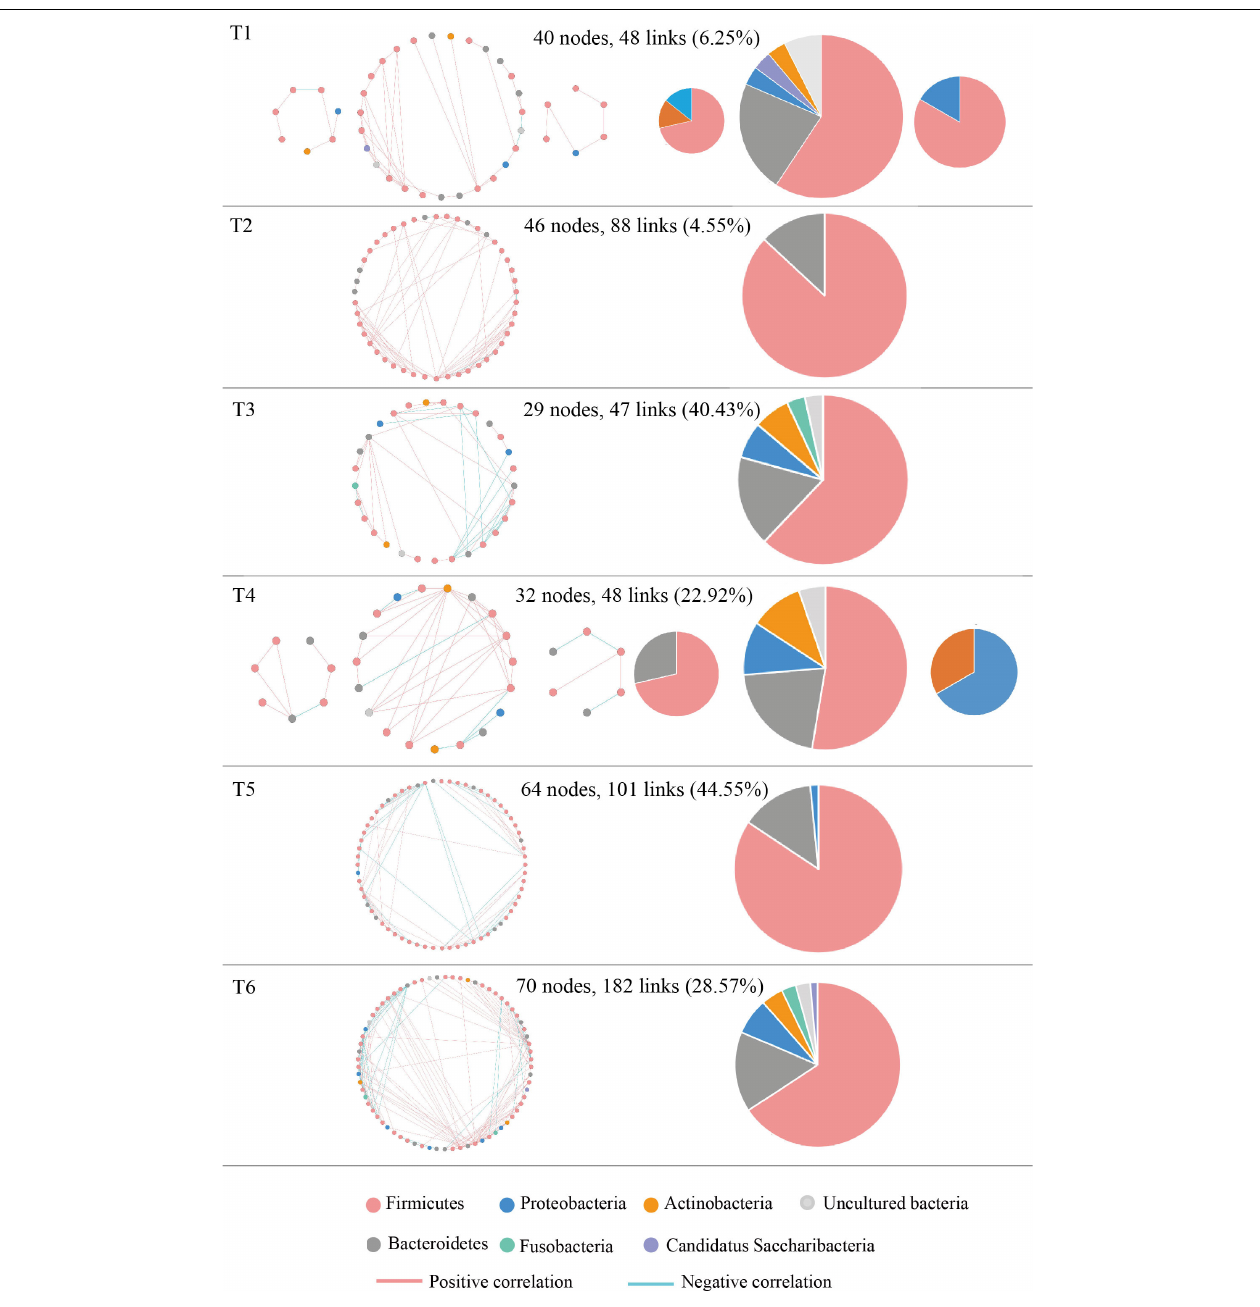
FIGURE 5 | Highly connected modules with intestinal microbial networks of NSCLC patients in response to osimertinib therapy. Node colors represent different phyla; pie charts represent the composition of the modules. A blue link indicates a negative relationship between two phyla, whereas a pink indicates a positive relationship. The number in bracket means the ratio of negative links accounting for the total